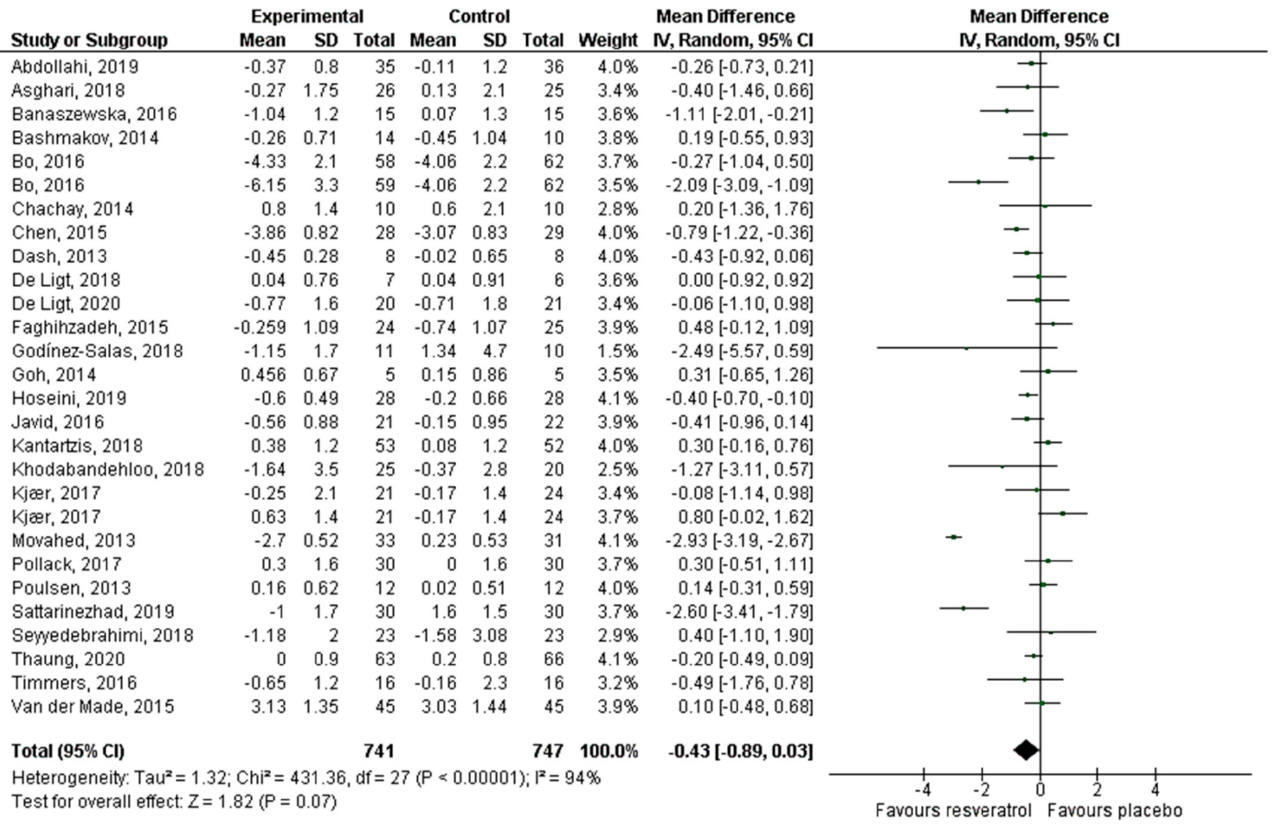
Figure 6. Effect of resveratrol on